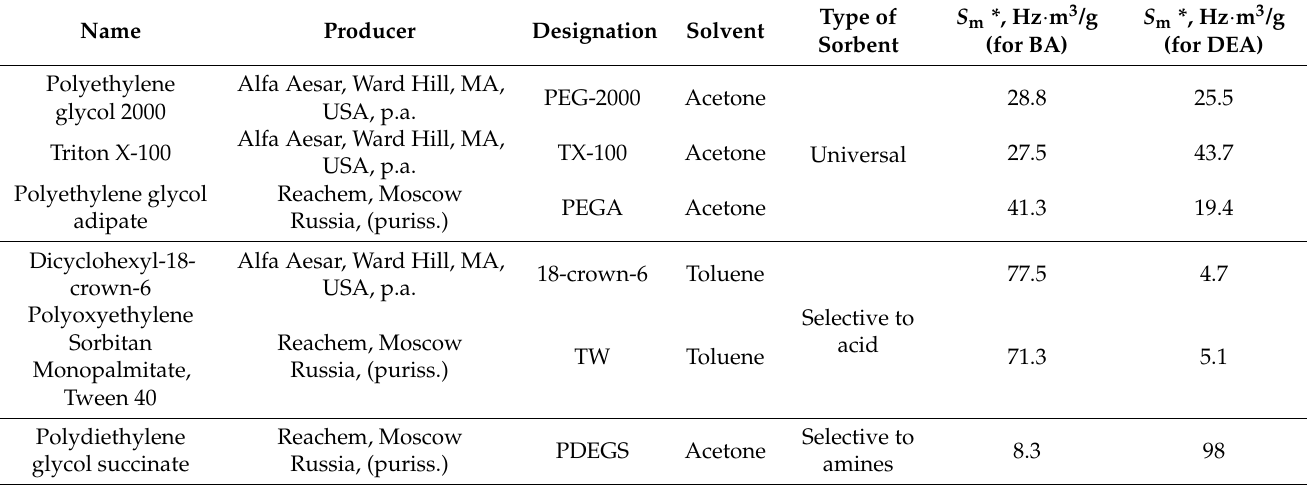
Table 2. Characteristics of sorbents for modifiers of electrodes of piezoelectric quartz